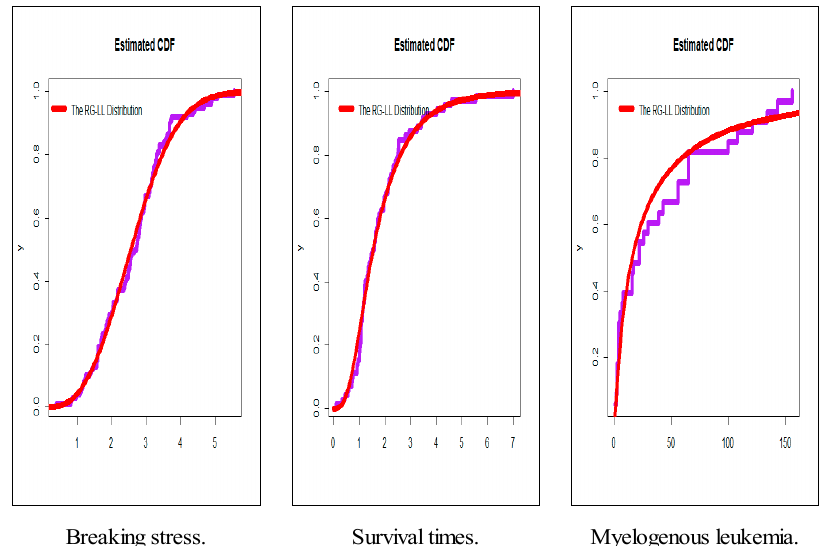
Figure 2. Total time test (TTT) plots.